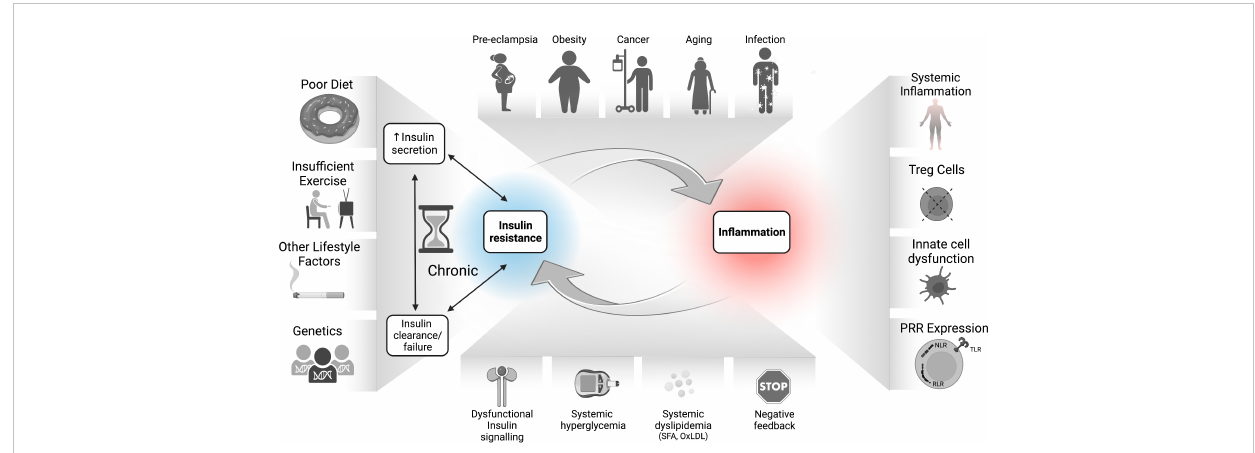
FIGURE 3 The bidirectional relationship between IR and in fl ammation in the pathogenesis of in fl ammatory diseases. Environmental, genetic, and dietary factors and their in fl ammatory responses can lead to hyperinsulinemia which drives dysfunctional responses in immune cells, including increased in fl ammatory tone and altered Treg function. The sustained IR-associated hyperglycemia and dyslipidemia also drive SFA and OxLDL production, increased RAGE activation, epigenetic changes, and accumulation of negative feedback signals on the InsR. Together with increased in fl ammation and PRR signaling, these immune/metabolic changes lead to whole-body as well as potentially immune cell-intrinsic IR. Immune cell IR in turn may undermine protective immunity and/or immune tolerance, which further exacerbates disease pathology. IR, insulin resistance; NF-kB, nuclear factor kappa B; mTORC1, mechanistic (or mammalian) target of rapamycin complex 1; NLR, nucleotide oligomerization domain (NOD)-like receptors; OxLDL, oxidized low density lipoprotein (LDL); PRR, pattern recognition receptor; RAGEs, receptor for advanced glycation end products; RLR, retinoic acid-inducible gene I-like receptors; SFA, saturated fatty acids; TLR, toll-like receptors; Treg, regulatory T